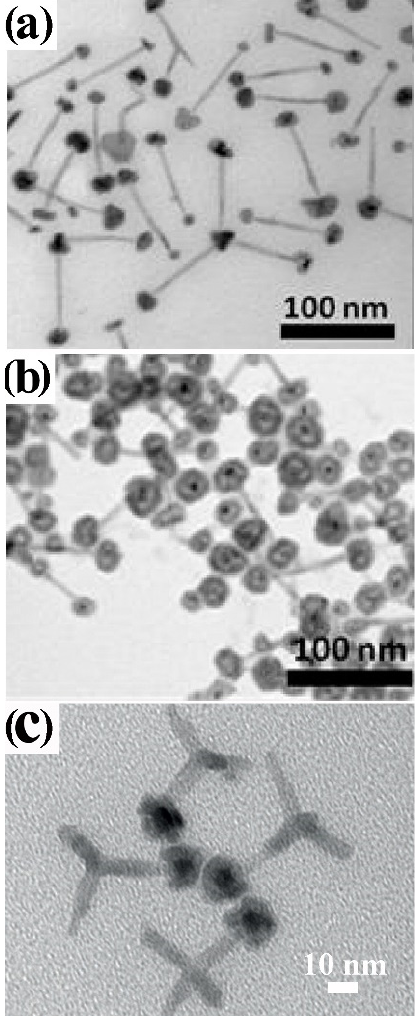
Figure 11. Representative anisotropic CNHSs synthesized by regioselective heterogeneous deposition on preformed rod-like and polypod-like seeds (cf. Scheme 4). ( a ) Nanodumbbel-like CNHSs com- posed of Pt@Co–tipped CdS nanorods, which were obtained overgrowing Co domains on the apexes of preformed Pt–tipped CdS nanorods and ( b ) nanodumbbel-like CNHSs made of Pt@Co x O y –tipped CdS nanorods with Pt@Co x Oy yolk@shell heads, which were prepared by oxidizing the Co domains of parent Pt@Co–tipped CdS nanorods (reproduced with permission from Ref. [346], Copyright 2012, American Chemical Society; ( c ) CdSe@CdS core@shell tetrapods asymmetrically decorated with a single Au@Co/Co x O y core@shell head (reproduced with permission from Ref. [348], Copyright 2016, Wiley-VCH Verlag GmbH & Co.